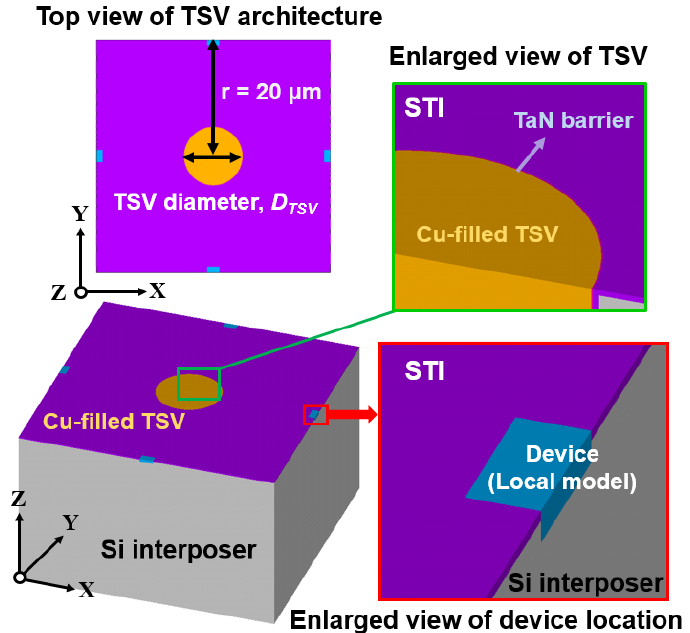
Figure 3. Schematic of a single TSV unit FEA model in an array-type TSV interposer and the corresponding structural parameters and materials. The TSV pitch is designed as 40 µ m in this study.